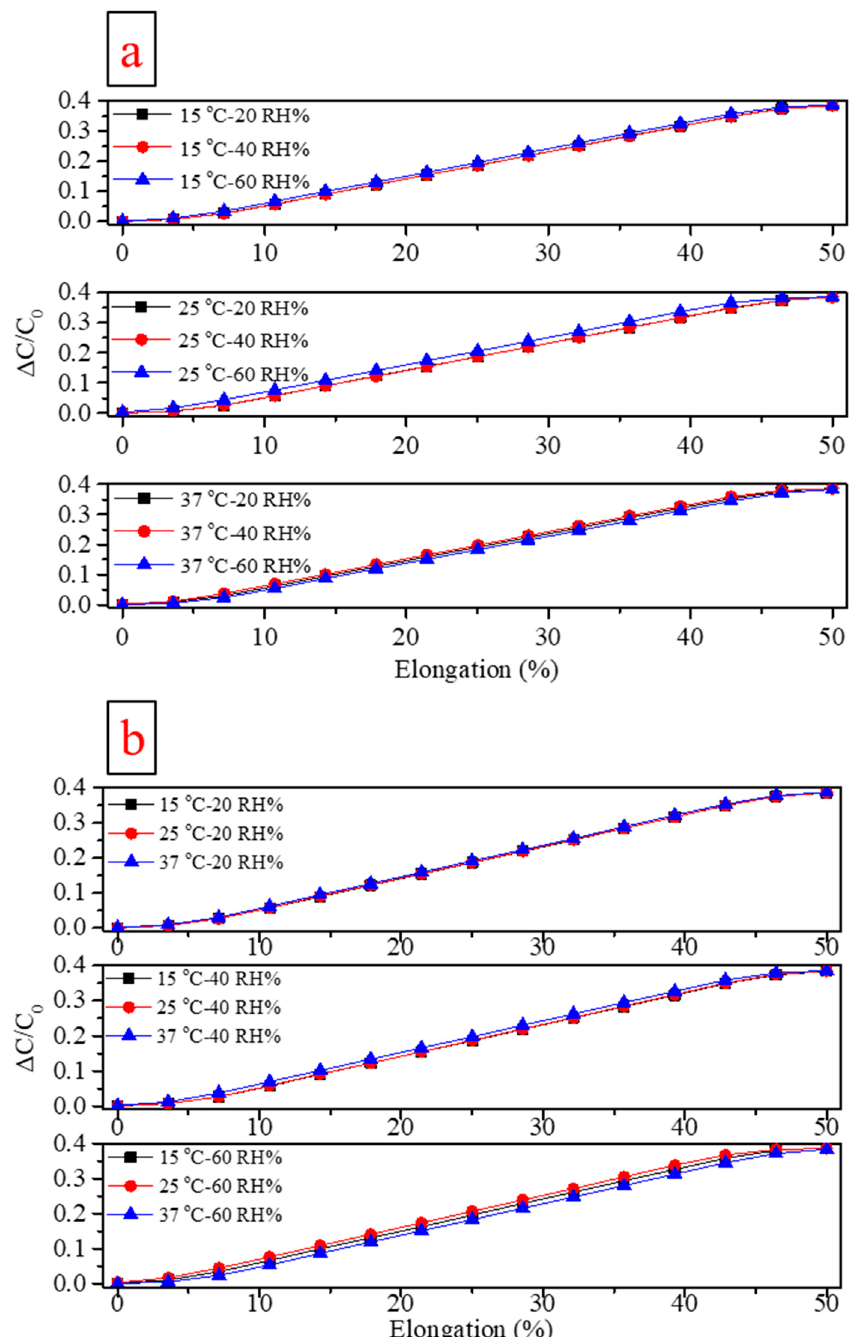
Figure 3. ( a ) Sensor capacitance measurements of 0 to 50% strain at constant temperature and varying humidity, recorded at 0.5 Hz strain rate. ( b ) Capacitance measurements at constant humidity and varying temperature, recorded at 0.5 Hz strain rate.